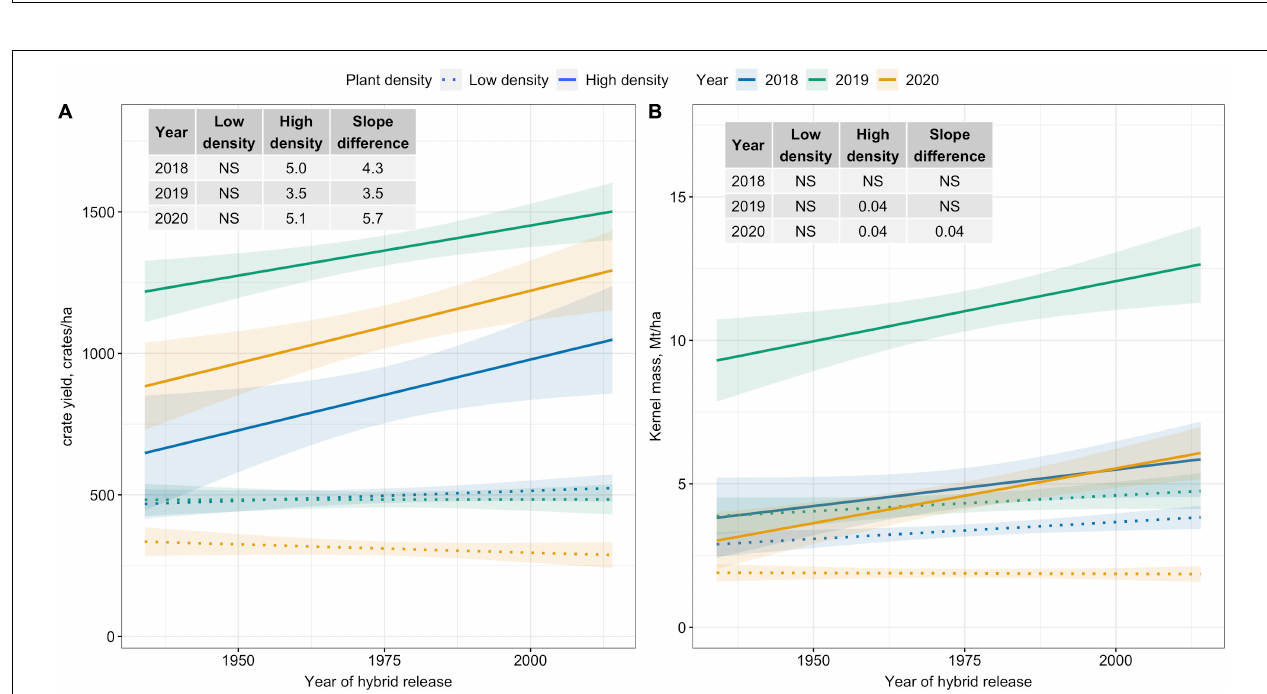
FIGURE 2 | Best fit line for relationship between year of hybrid release and (A) crate yield (crates/ha), and (B) kernel mass (Mt/ha) for two levels of plant density at Urbana, IL in 2018–2020. Crate yield is the total number of crates, each filled with 48 marketable ears, produced per hectare. Ninety-five percent confidence intervals are shown by the shaded regions around the line of best fit. Slope estimates from linear regression analysis for Low plant density (9,900 plants/ha), High plant density (79,000 plants/ha), and difference between two plant densities are shown. Non-significant slope estimates are denoted by NS ( α = 0 . 05).